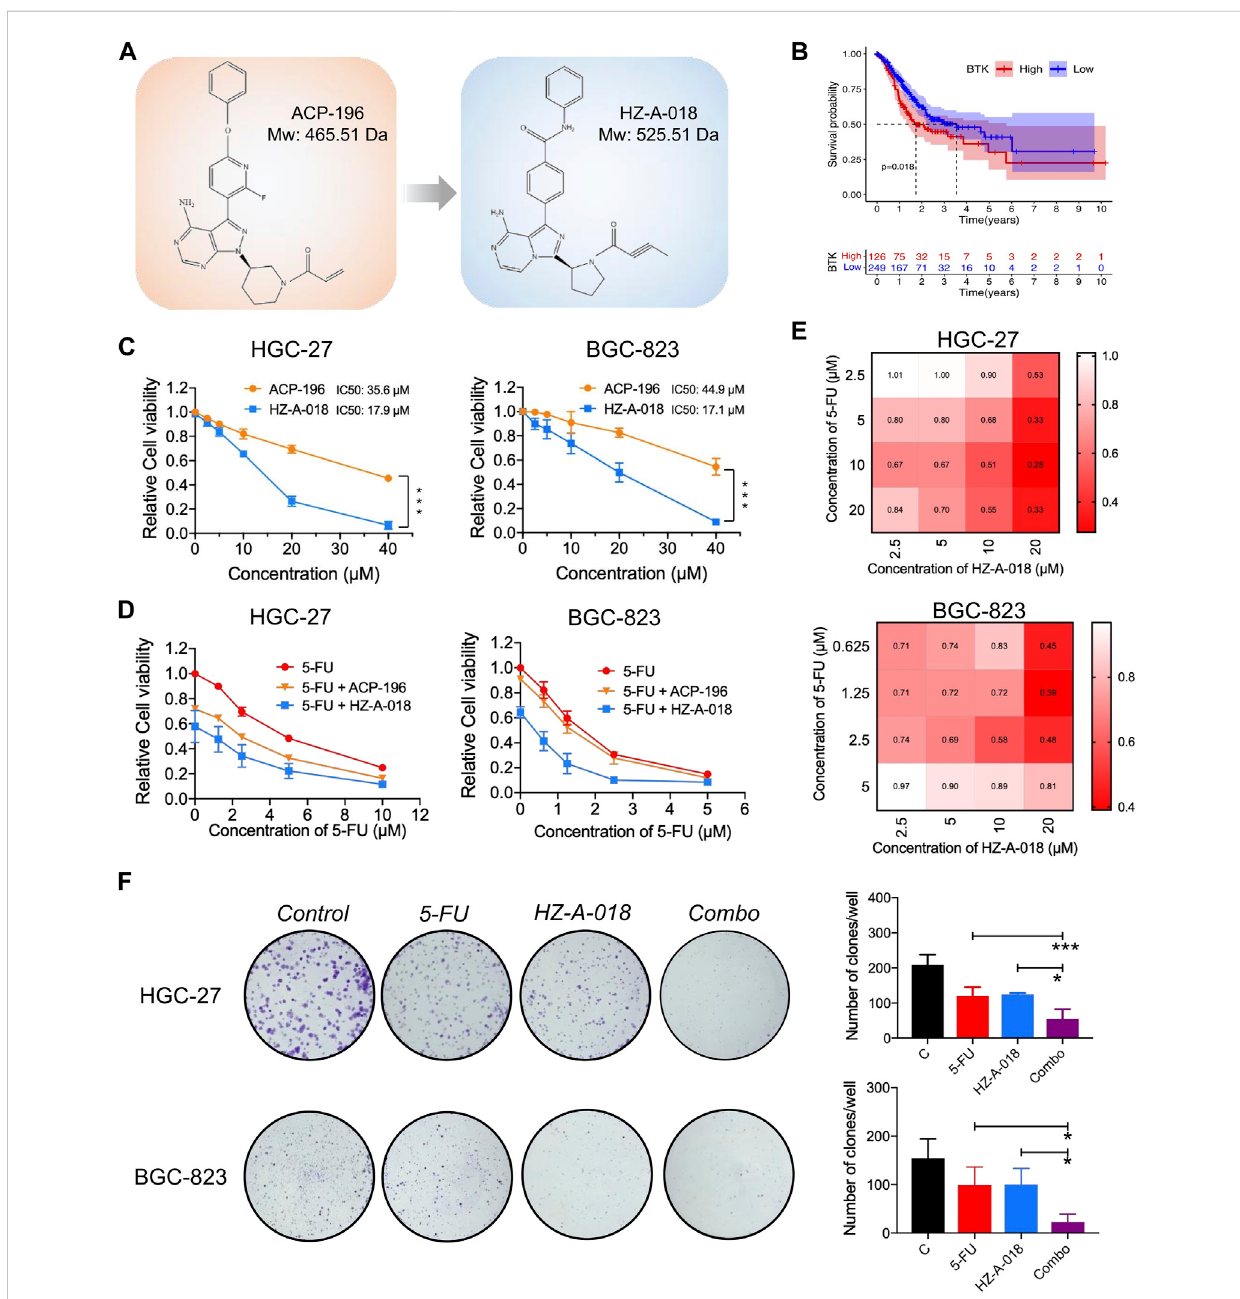
FIGURE 1 The anti-proliferative effects of HZ-A-018, ACP-196 and 5-FU in gastric cancer cells. (A) The chemical structure sketch of ACP-196 and HZ-A-018. (B) Comparison of survival between low expression and high expression of BTK. The expression data and clinical survival of gastric cancer patients were obtained from UCSC Xena (https://xenabrowser.net/). A total of 375 samples were included. (C) The relative cell viability after treatment with different concentrations of ACP-196 or HZ-A-018 for 72 h in HGC-27 and BGC-823 cells. (D) The relative cell viability after combinatorial treatment with various concentrations of 5-FU and 10 µM of ACP-196 or HZ-A-018 for 72 h in HGC-27 and BGC-823 cells. (E) The calculated combination index (CI) basedoncombinatorialtreatmentwith5-FUandHZ-A-018. (F) Theinhibitoryeffectsoncolonyformationaftercombinedtreatmentwith5-FU(2.5 µMin HGC-27 cells and 0.25 µM in BGC-823 cells) and 10 µM of HZ-A-018. * p < 0.05, ** p <